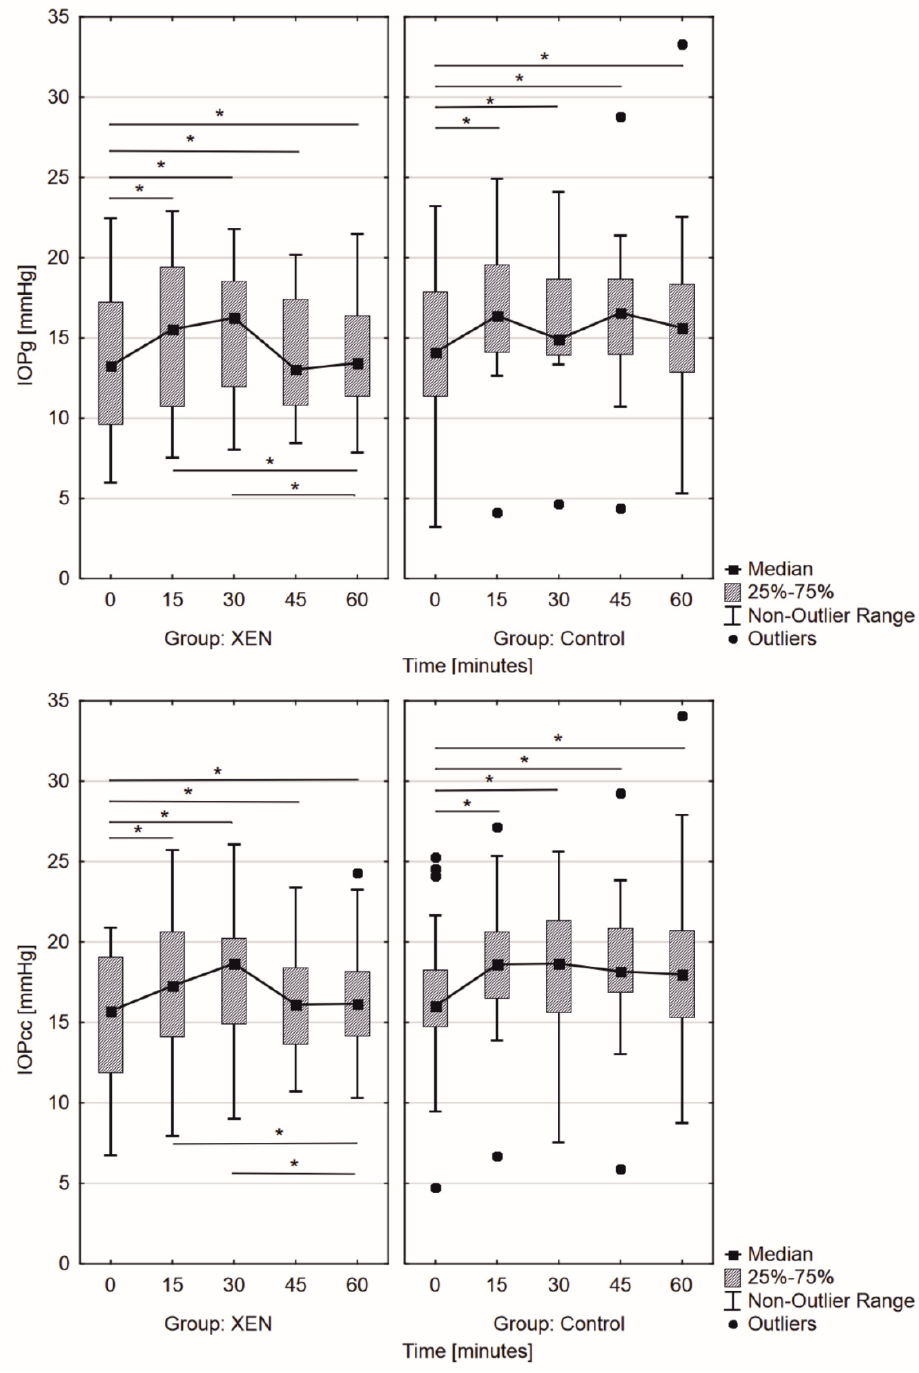
Figure 5. Changes in ( top ) Goldman-compensated intraocular pressure measured (IOP G ) and ( bottom ) corneal-compensated intraocular pressure (IOP CC ) measured by Ocular Response Analyzer during the water drinking test in the examined groups. (* p < 0.05, Friedmann test).